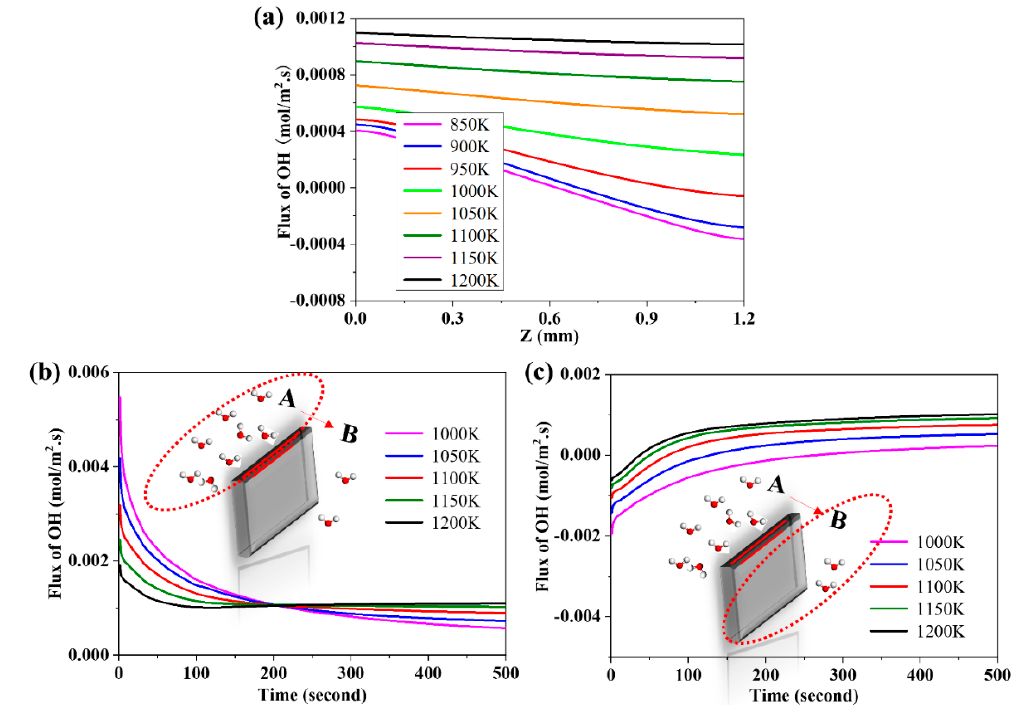
Figure 8. ( a ) The effect of temperature on the flux of proton; ( b ) the evolution of the flux of proton at Side A; and ( c ) the evolution of the flux of proton at Side B.